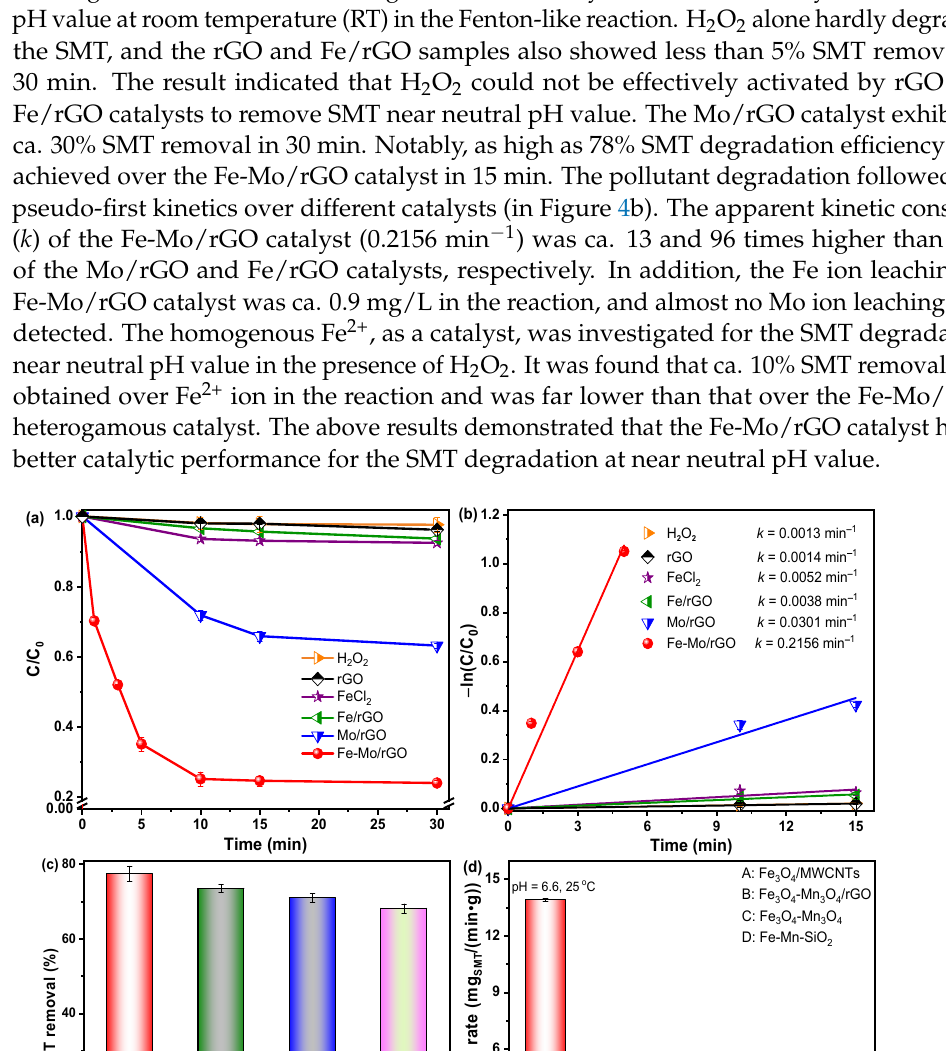
Table 1. The SMT degradation over different iron-based catalysts in Fenton-like reaction.